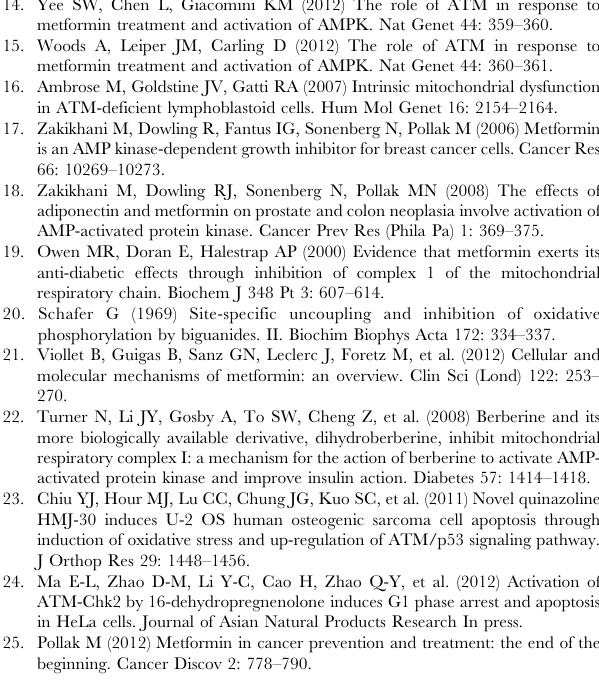
(TIFF) Figure S2 Cytograms of PI uptake (ordinate) vs. annexin V binding (abscissa). Apoptotic (annexin V + /PI 2 ), vital (V 2 / PI 2 ), and damaged (annexin V 2 / PI + ) cells are shown. Cells displayed an increase in cell death and apoptosis when treated with KU-55933 (TIFF) Table S1 Significance of differences in metabolites levels in